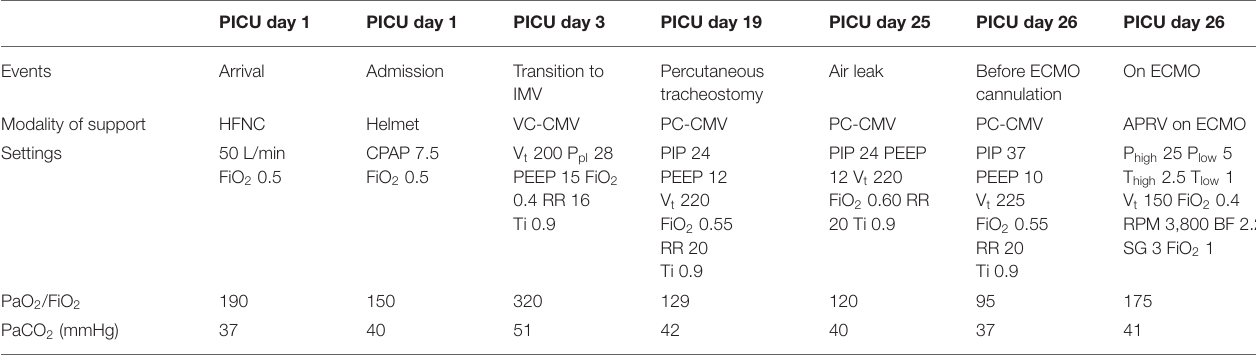
TABLE 1 | Clinical course of ARDS.